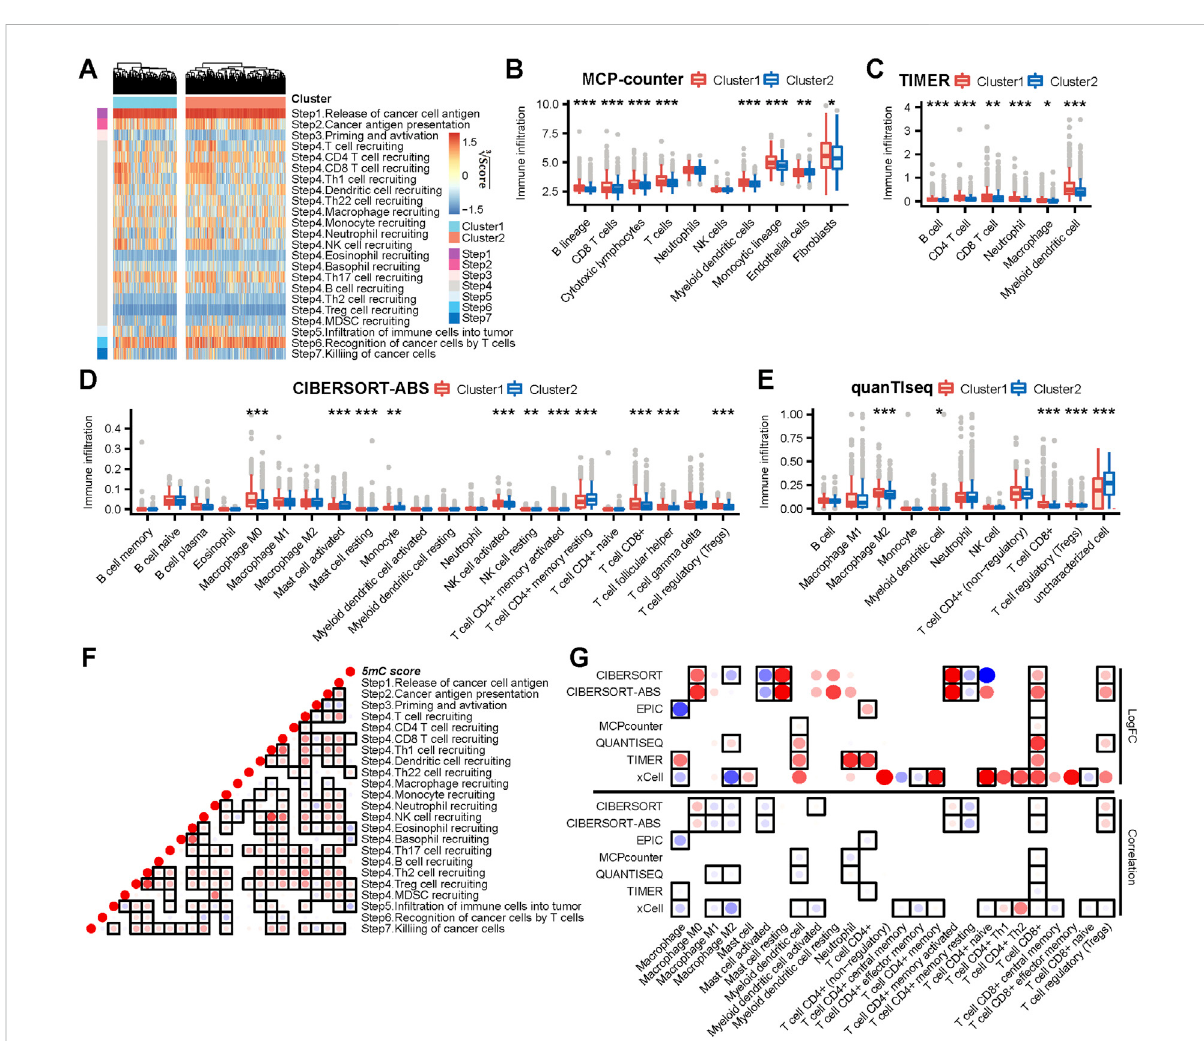
FIGURE 3 The5 mCclustersand5 mCscorecorrelatedwithimmunephenotypesinmetacohort. (A) ThessGSEAscoreheatmapofsevenstepsincancer immunity cycles. (B – E) The differences in in fi ltration levels of immune cells between 5 mC clusters in the MCP-counter, TIMER, CIBERSORT-ABS, and quanTIseq algorithms. (F) The correlations between the 5 mC score and steps in cancer immunity cycles. Each point reports the correlation resulting from correlating 5 mC scores and ssGSEA scores of each step in the cancer immunity cycle. The points are color-coded based on correlation. The red color indicates a positive correlation, whereas the blue color represents a negative correlation. The light color represents a low correlation and the progressively darker color represents a higher correlation. The black box represents a signi fi cant correlation ( p < 0.05). (G) The upper panel indicates that the logFC of the main type of immune cells between clusters 1 and 2. The bottom panel indicates that the correlation between the main type of immune cell and 5 mC scores. The darker red colors represent a higher logFC or a more positive correlation. The darker bluecolorsrepresentalowerlogFCoramorenegativecorrelation.Thepointsarecolor-codedbythelogFC(upper)orcorrelation(bottom).Thered color indicates a positive logFC (upper) or correlation (bottom). The blue color represents a negative logFC (upper) or correlation (bottom). The light color represents a low absolute value of logFC (upper) or a correlation (bottom). In contrast, progressively darker colors represent a higher absolute value of logFC (upper) or a correlation (bottom). The black box represents a signi fi cant correlation ( p < 0.05). * p < 0.05, ** p < 0.01, *** p <